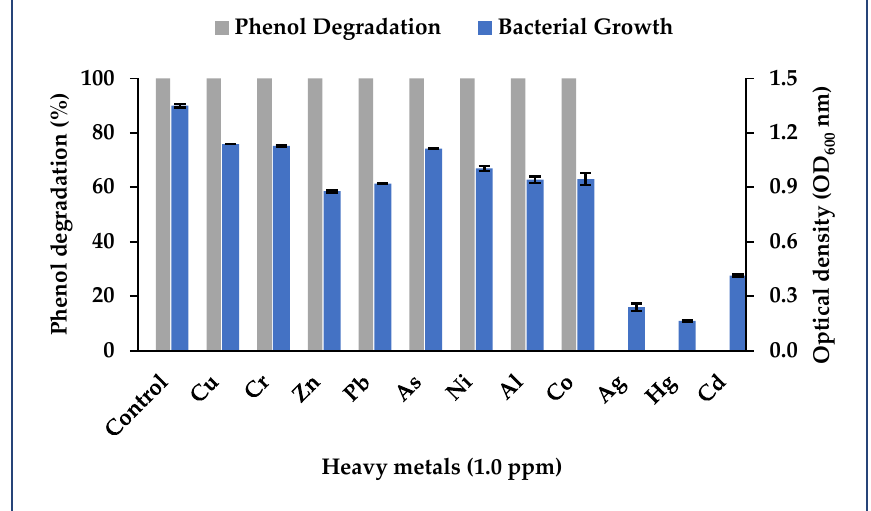
Figure 10. Effects of 1.0 ppm concentration of different heavy metals on phenol degradation and growth on the binary consortium. Error bars represent the mean ± standard deviation of three replicates.